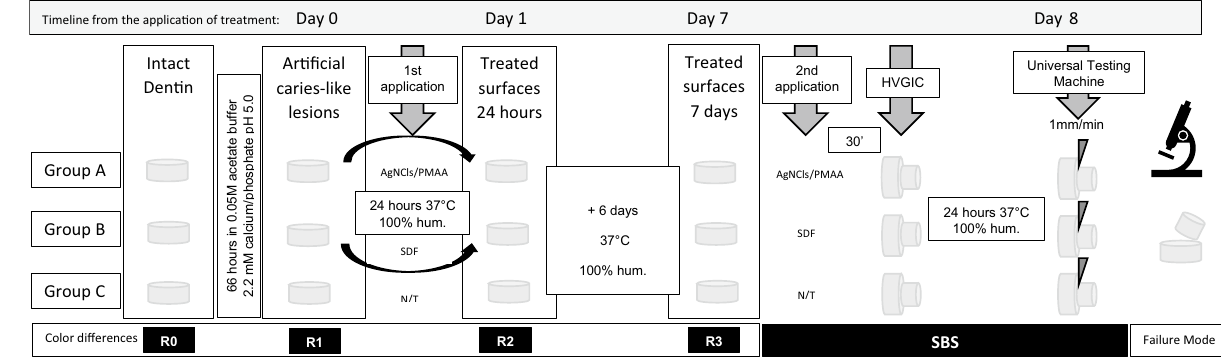
Figure 1. Timeline of the study. Sequence for testing color changes and SBS of the